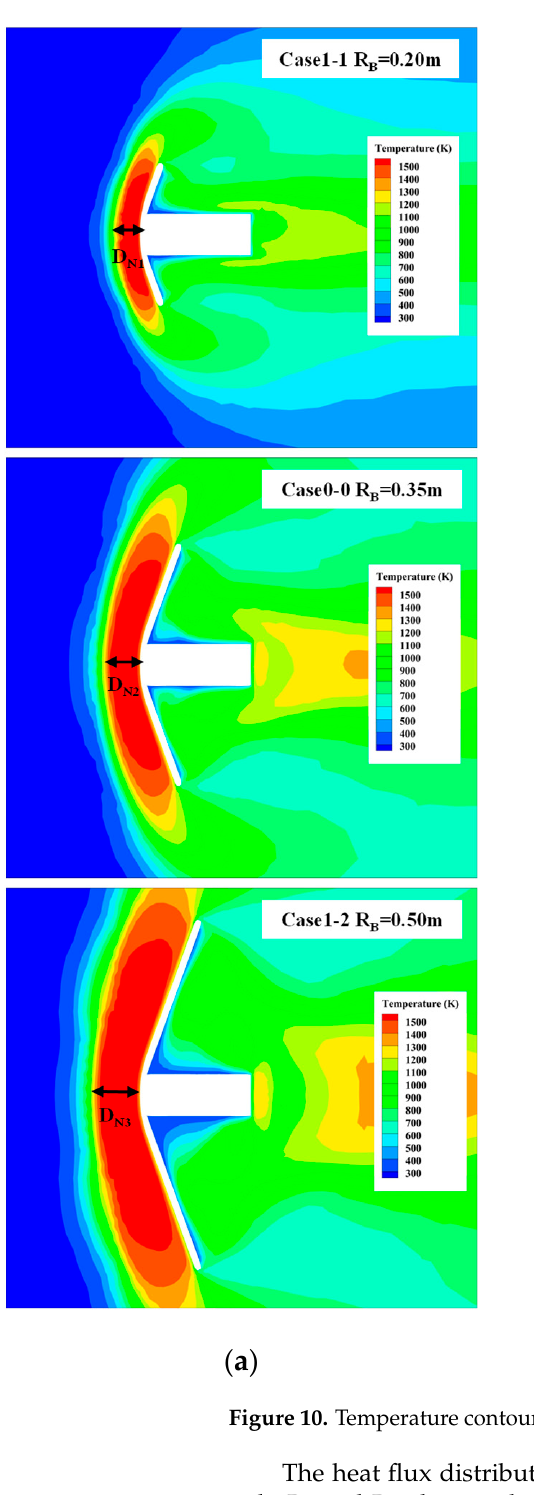
( b ) Figure 11. Heat fl ux distribution of case 0-0, case 1-1 to case 2-2: ( a ) R B is changed; ( b ) R N is changed.